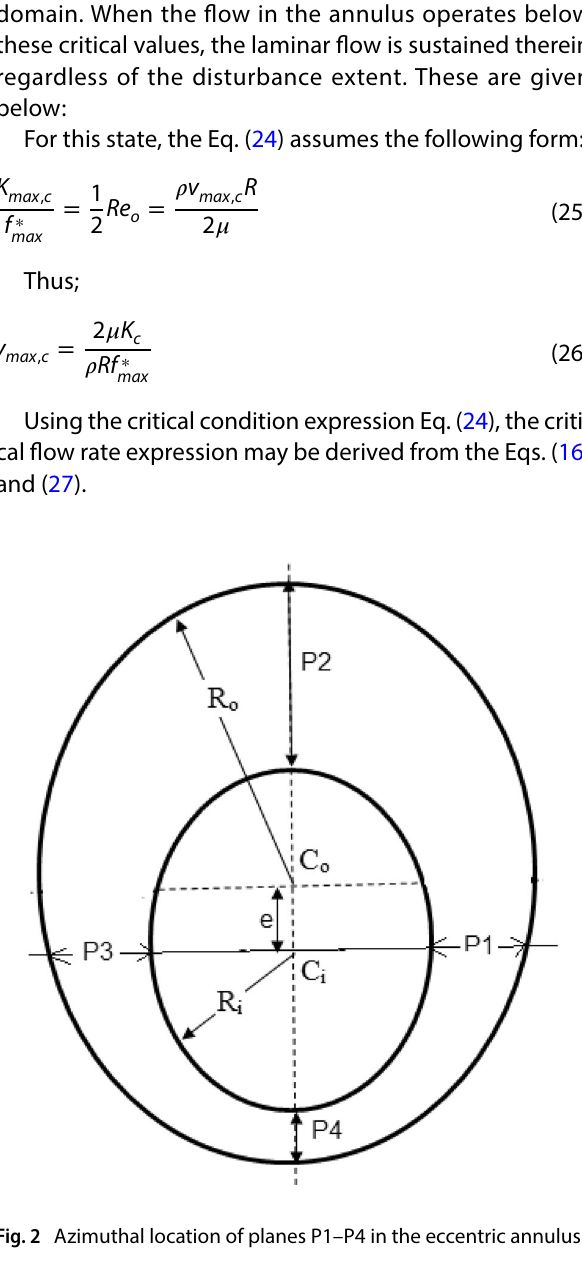
Table 1 Azimuthal location and its radial coordinate for the various planes